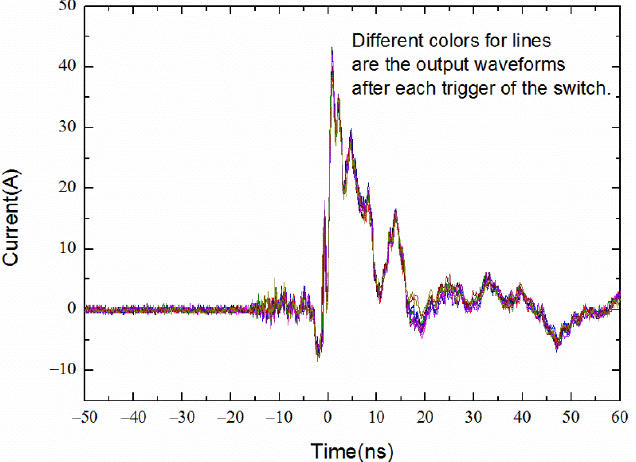
Figure 10. Ten repetitive output waveforms of the 10 mm GaAs PCSS biased at 35 kV.